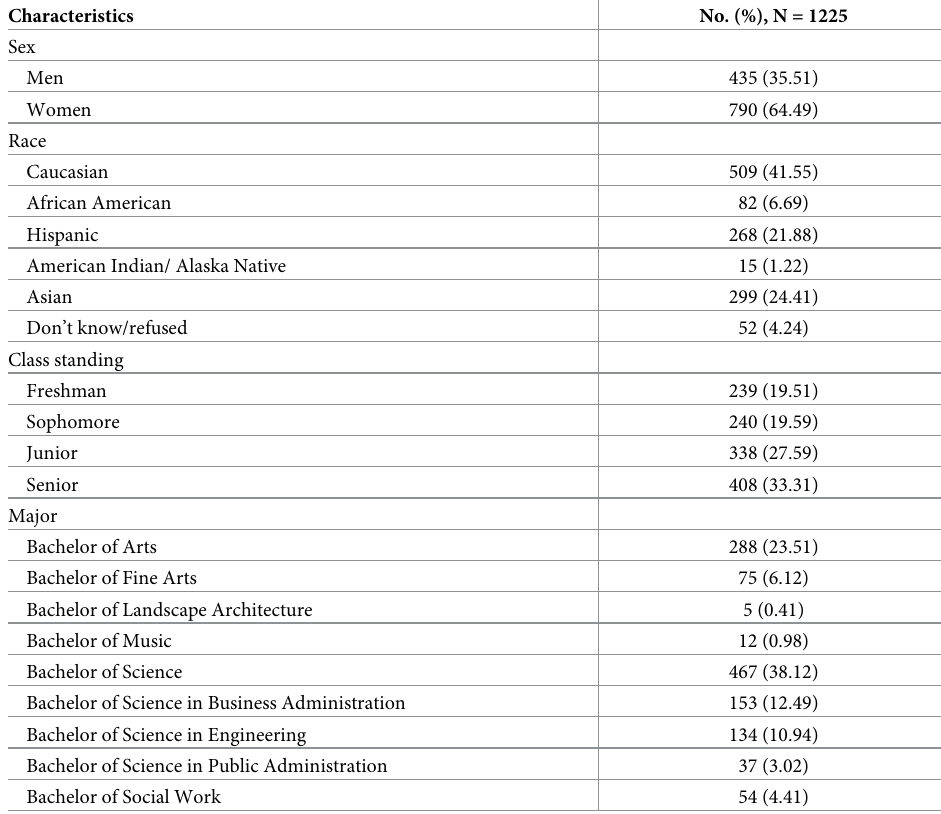
Table 1. Respondent demographic